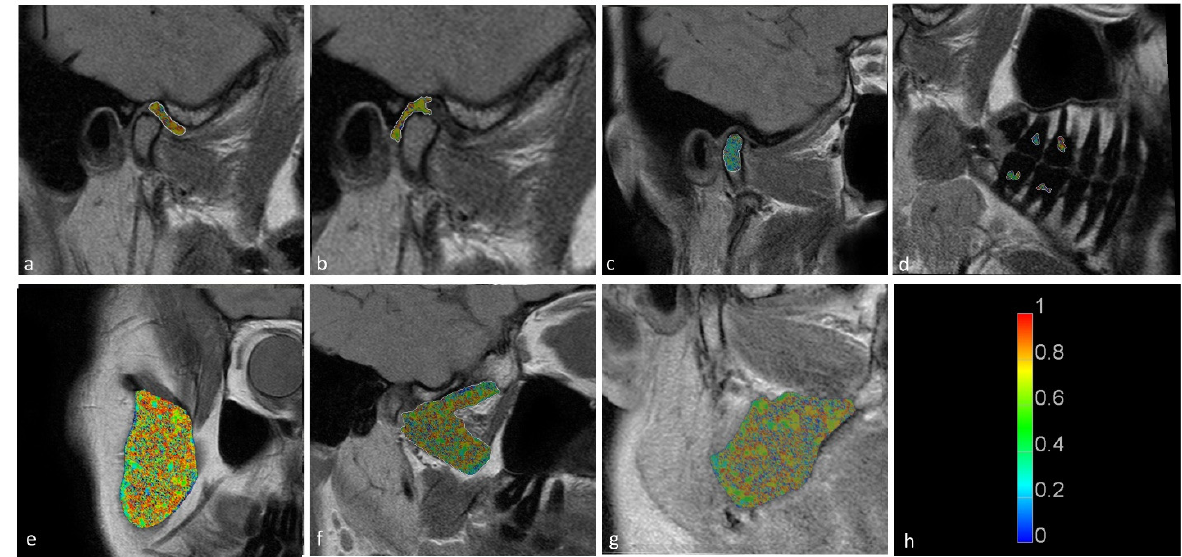
Figure 4. Short fraction components for the ( a ) disk; ( b ) retrodiscal tissue; ( c ) bone marrow of the condyloid process; ( d ) pulp; ( e ) m. masseter; ( f ) m. pterygoideus lateralis; and ( g ) m. pterygoideus medialis. ( h ) Color scale showing the reference values.